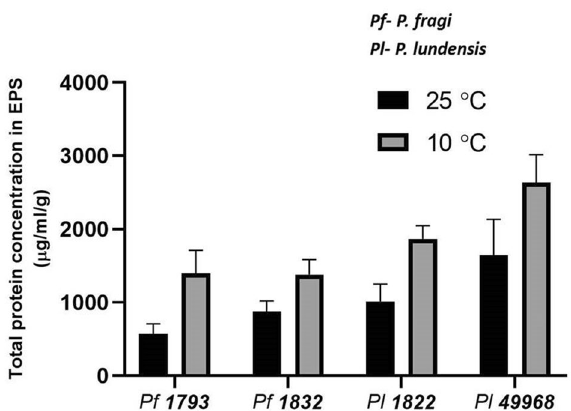
Figure 1. The total protein content of the matrix EPS. The protein content of soluble and bound fractions of extracted EPS of P. fragi (1793 and 1832) and P. lundensis (1822 and ATCC 49968) biofilms formed on nitro- cellulose membrane placed on meat at 10 °C and 25